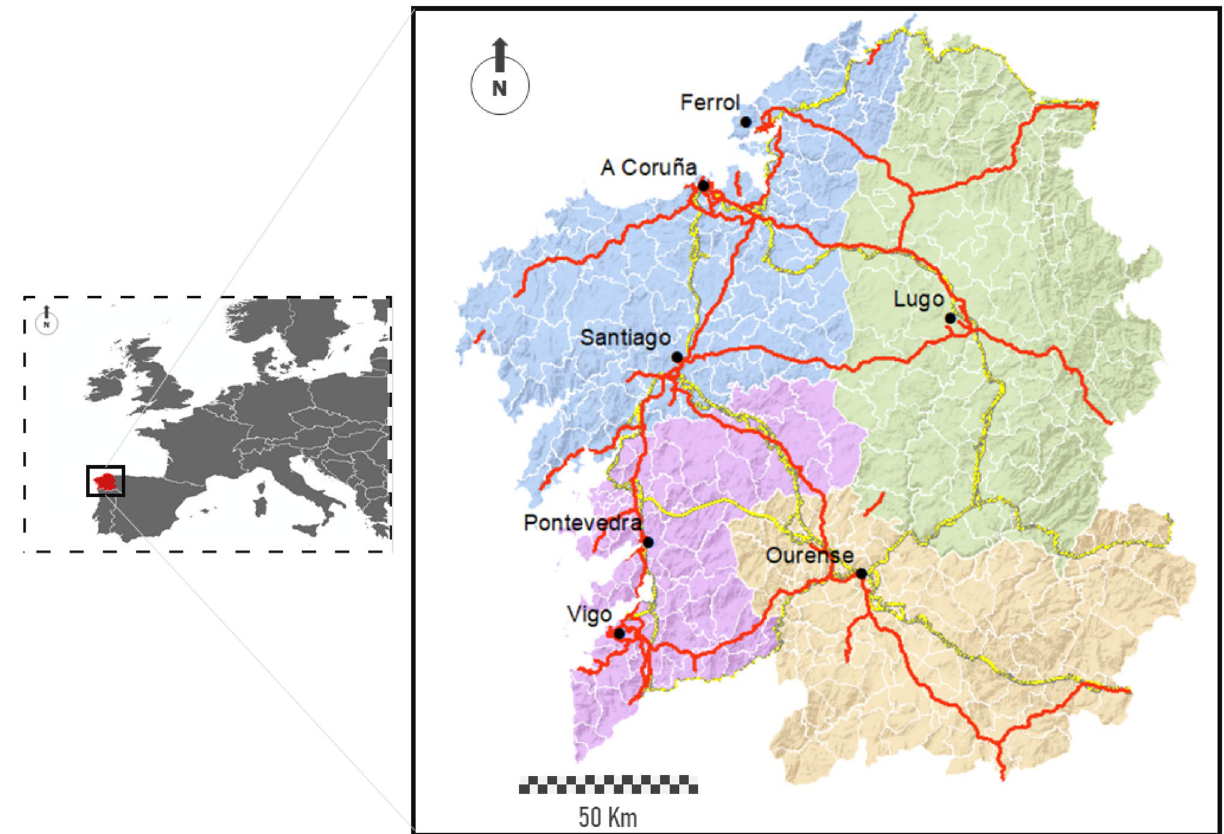
Figure 1. Location and characterization of the Galician region. In colored background, distribution in provinces (second-level administrations) and municipalities (third-level administrations). The most populated cities and industrial hubs of each province appear highlighted in bold. Red lines represent the major road infrastructures, i.e., motorways in red and railways in yellow. Maps are generated using ArcGIS Desktop software version 10.8 (from ESRI, https:// www. esri. com/ en- us/ arcgis/ produ cts/ arcgis- deskt op/ overv